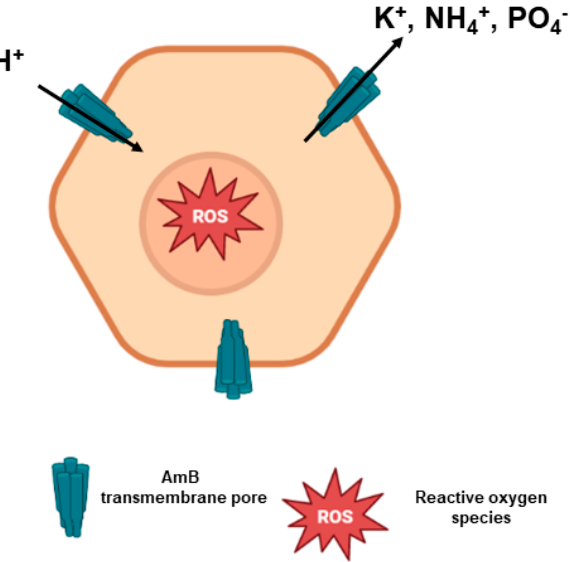
Figure 4. Mode of action of AmB. AmB molecules interact with ergosterol, forming AmB transmem- brane pores. There is an intense efflux of ions through these pores that eventually leads to proton influx, causing cell death. Moreover, there is a production of reactive oxygen species (ROS) due to AmB-mediated oxidative stress when the drug crosses the cell membrane.